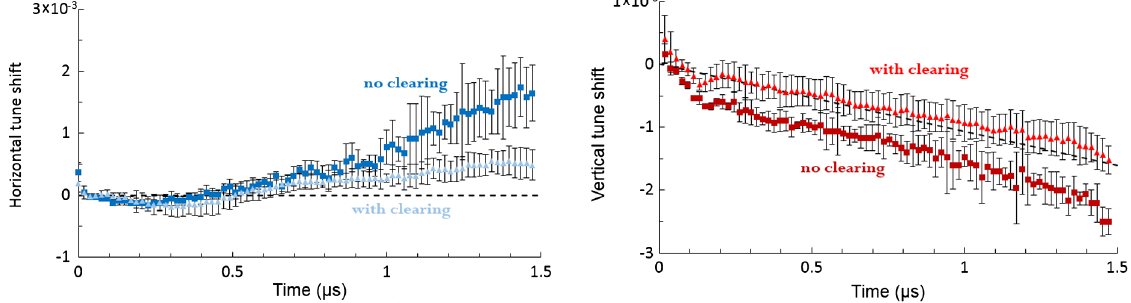
FIG. 8. Presence of the clearing bunch reduces the tune shift between the head and the tail of the high-intensity bunch train: 5 × 10 10 ppb, 80 bunches. The error bars represent the spread between different measurements. The dashed lines correspond to the estimated resistive wall contributions, found by extrapolating measurements at lower intensities.